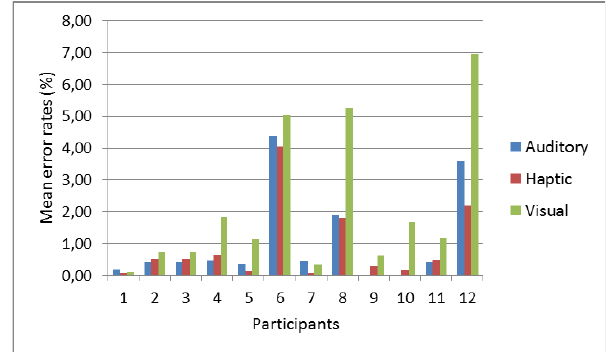
Figure 6. Mean error rates (%) per each feedback mode illustrate the great variability between